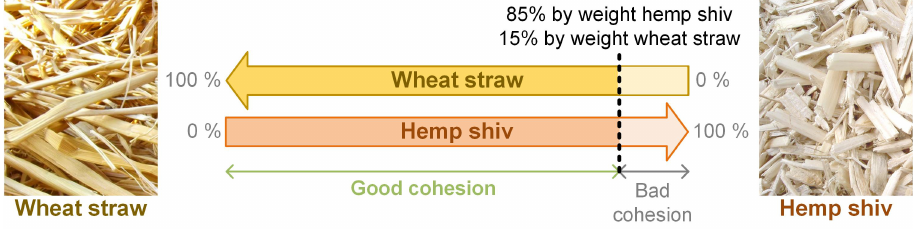
Figure 2. Cohesion versus formulation of hemp shiv-milled wheat straw composites.